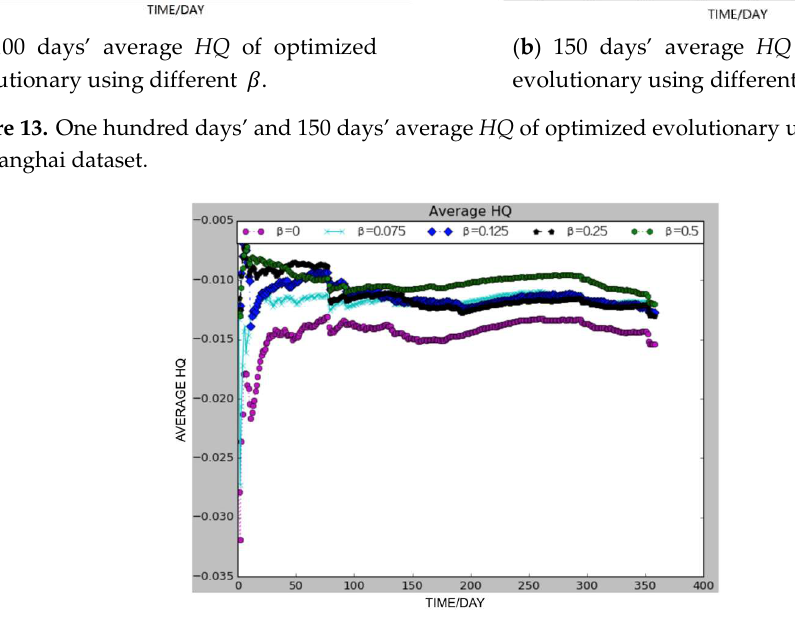
Figure 14. One-year average SQ of optimized evolutionary using different 𝛽 in LD2011_2014 dataset.